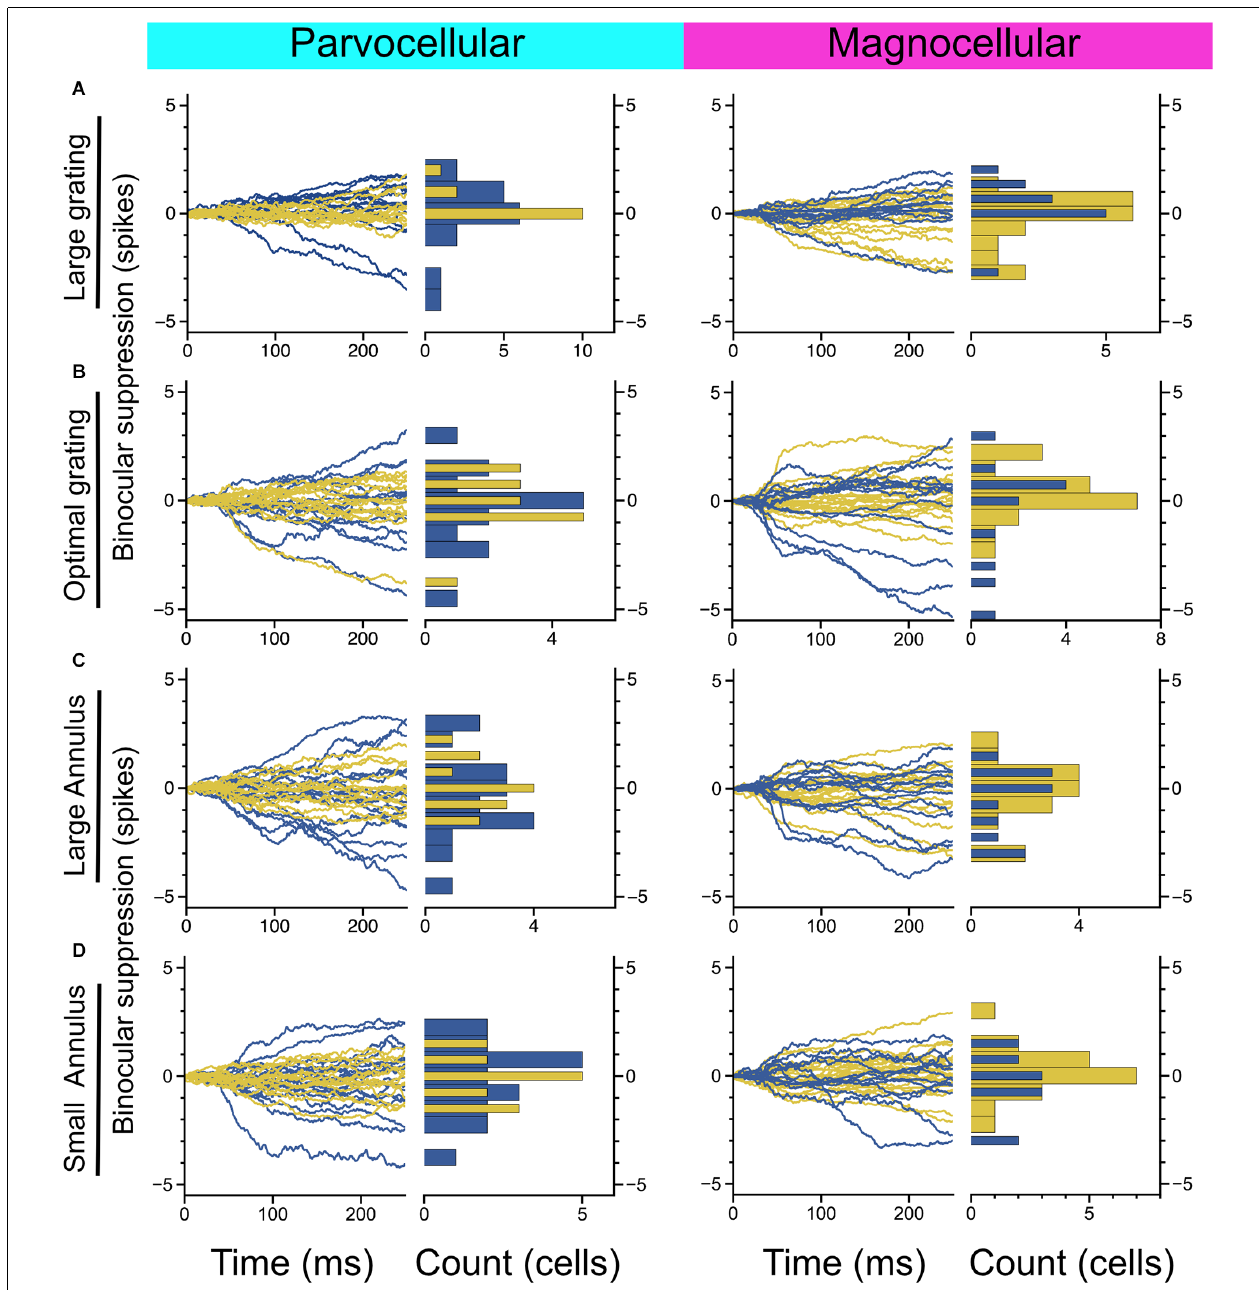
FIGURE 3 | Measurement of binocular interaction in On-cells and Off-cells of the parvocellular and magnocellular pathways. (A) Cumulative differences in spiking elicited by a large-sized probe grating presented to the dominant eye alone vs. with a large grating presented to the non-dominant eye. (B) Cumulative differences in spiking elicited by an optimally-sized probe grating presented to the dominant eye alone vs. with an equally-sized grating presented to the non-dominant eye. (C,D) Cumulative differences in spiking elicited by an optimally-sized probe grating presented to the dominant eye alone vs. with a large annulus (C) or small annulus (D) presented to the non-dominant eye. Stimulus configuration is stated to the left of